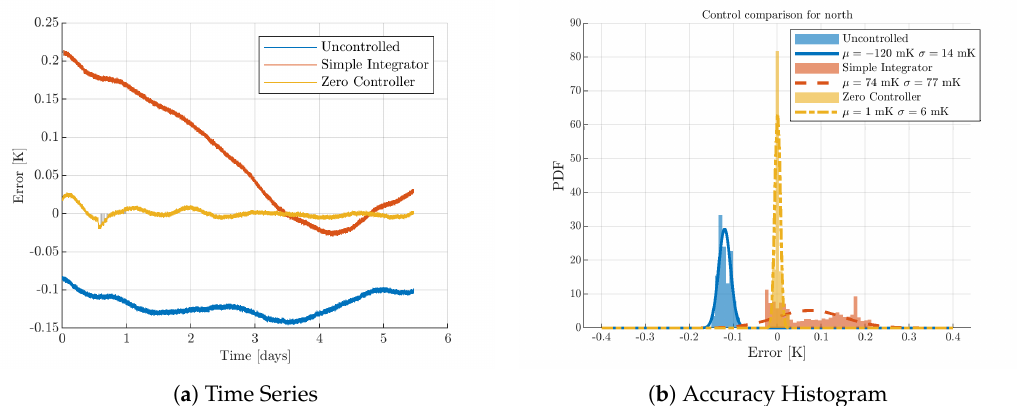
Figure 8. Probability density function of mirror temperature error comparing the accuracy of the simple integrator, zero controller, and uncontrolled cases during a lock period of 5.5 days. The zero controller has remarkably higher accuracy.